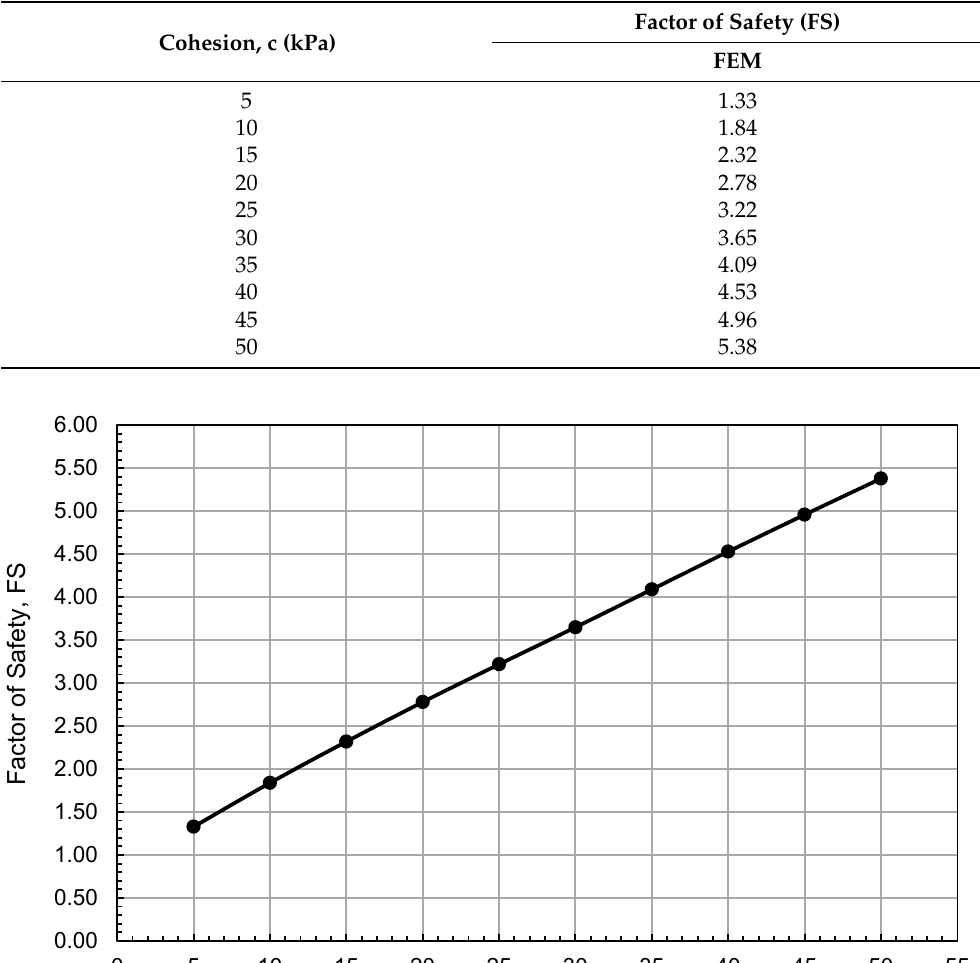
Table 10. Analysis results for different cohesion values (N = 4).